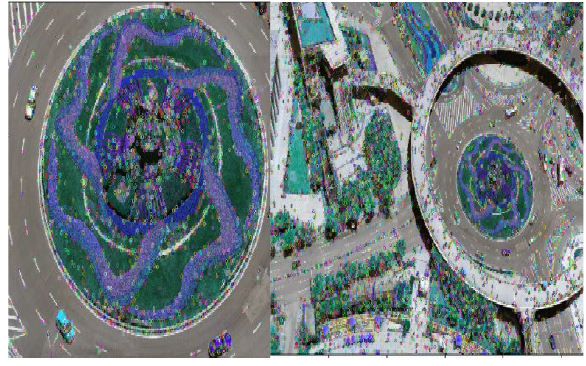
Figure 6. Determination of Image